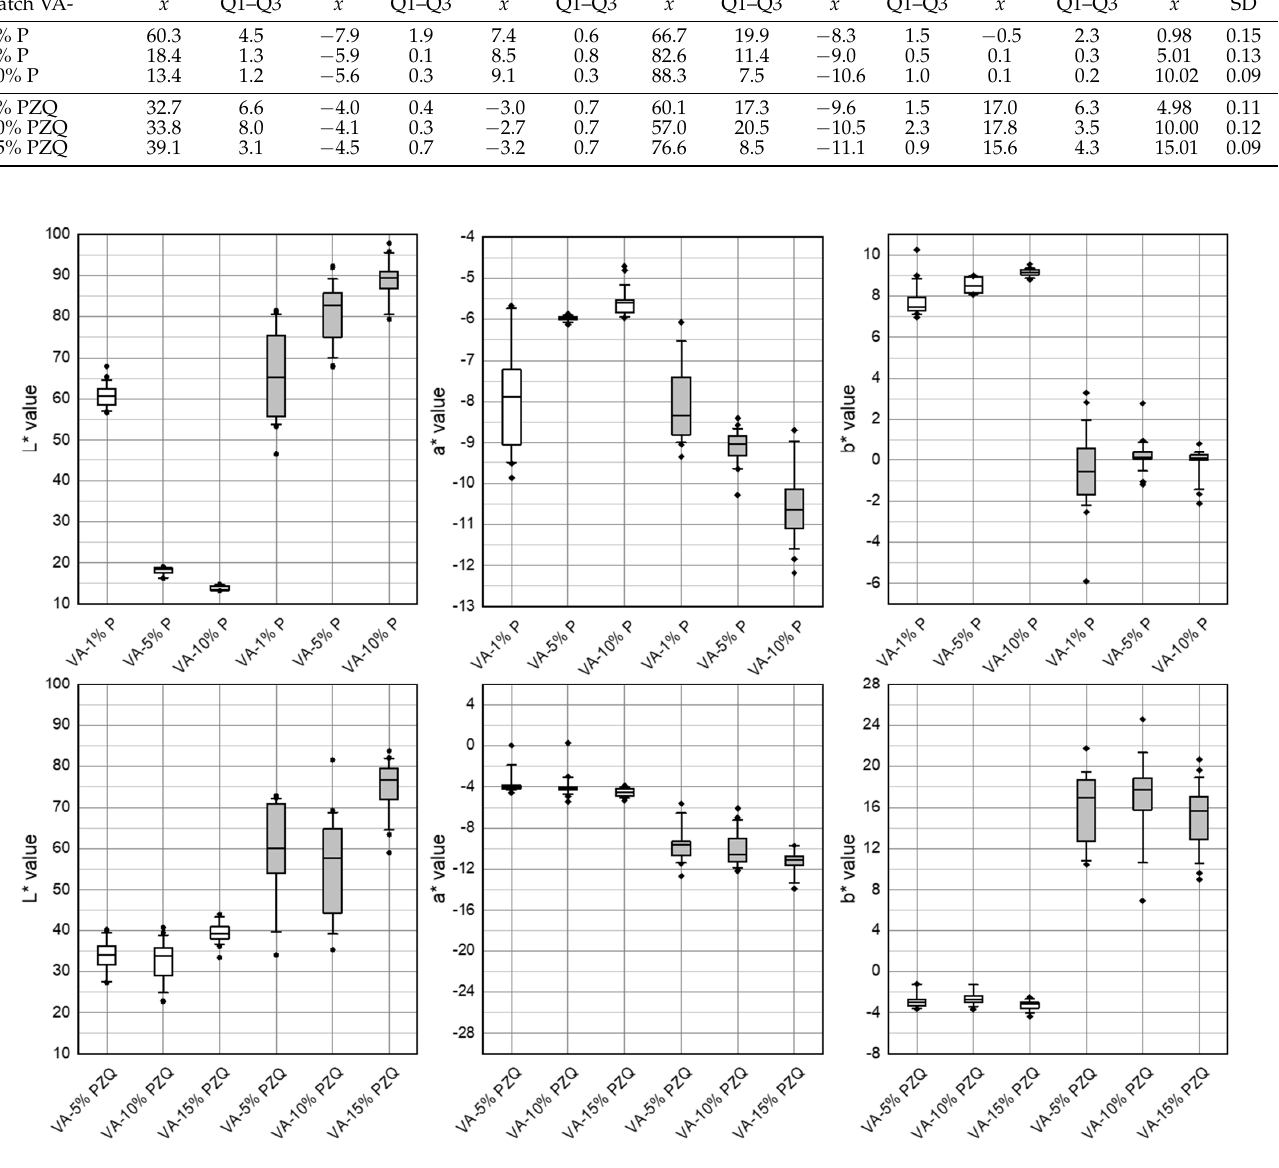
Figure 4. Box-whisker plots of L*a*b* values of transmission (white) and reflection (grey) measure- ment of VA-1,5,10% P and VA-5,10,15% PZQ filaments obtained with Setup 1 ( n = 10, Q1/Q3 ± 1.5 IQR,